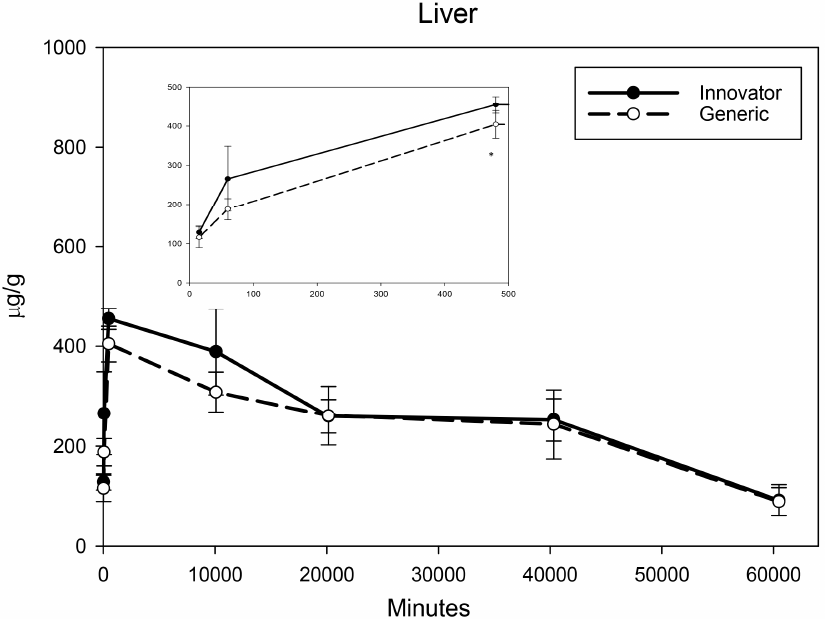
Figure 7. Liver mean iron concentrations over time. Endogenous (control) iron concentration was subtracted from both the innovator (solid) and the generic (dashed). Negative results are not graphed. Time points = 15 min, 60 min (1 h), 480 min (8 h), 10,080 min (1 week), 20,160 min (2 weeks), 40,320 min (4 weeks), 60,480 min (6 weeks). Inset shows the first three time points (15 min, 1 h, 8 h). Values are shown as mean + SD; n = 6 per group per time point; * p < 0.05.